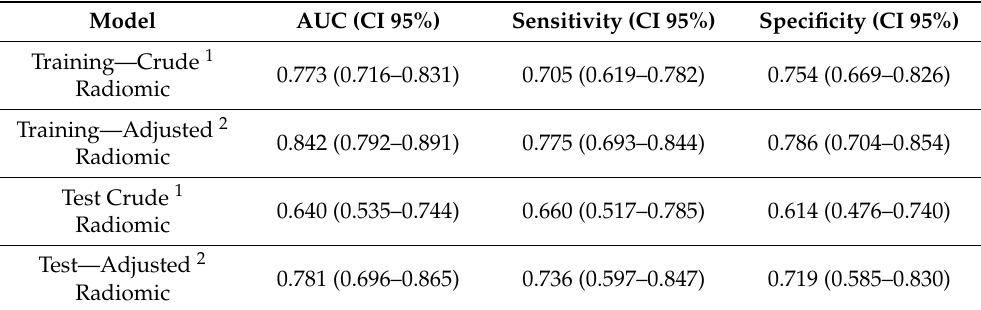
Table 3. Performances of the radiomic